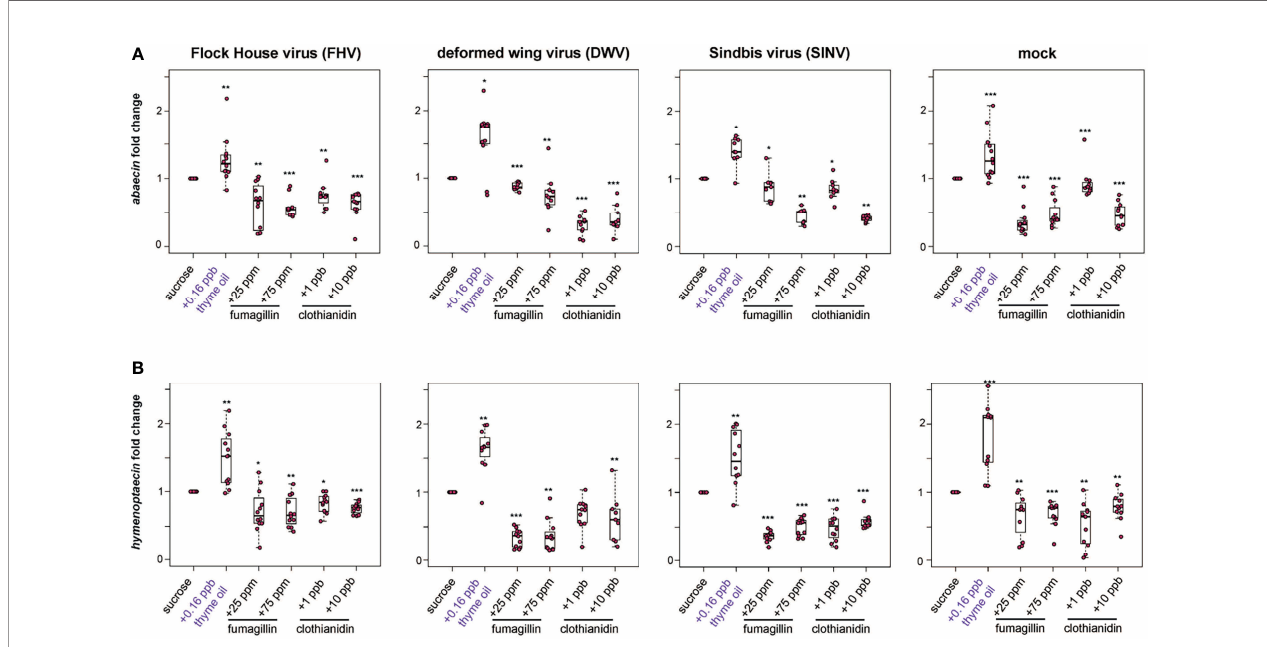
FIGURE 5 | Expression of antimicrobial peptides encoding genes was greater in bees fed thyme oil augmented sucrose syrup and lower in bees fed fumagillin or clothianidin containing sucrose syrup. The expression of two antimicrobial peptides ( abaecin and hymenoptaecin ) was assessed in mock and virus-infected bees fed sucrose syrup containing additives. (A) In virus- and mock-infected bees (i.e., FHV, DWV, SINV), abaecin expression was higher in bees fed sucrose syrup containing thyme oil and lower in bees fed sucrose syrup containing fumagillin (25 ppm or 75 ppm) or clothianidin (1 ppb or 10 ppb) compared to bees fed sucrose only. (B) In virus-infected bees (i.e., FHV, DWV, SINV), hymenoptaecin expression was higher in bees fed sucrose syrup containing thyme oil and lower in bees fed sucrose syrup containing fumagillin (25 ppm or 75 ppm) or clothianidin (1 ppb or 10 ppb). Hymenoptaecin expression was higher in mock-infected bees fed sucrose syrup augmented with 0.16 ppb thyme oil, but lower in mock-infected bees fed either fumagillin (i.e., 25 ppm or 75 ppm) or clothianidin (1 ppb or 10 ppb) containing sucrose syrup. Data were analyzed by a pairwise Wilcoxon Rank Sums with a Benjamini – Hochberg correction for multiple comparisons. Asterisks indicate a signi fi cant change in gene expression compared to sucrose only control; signi fi cance levels: * p < 0.05; ** p < 0.005; *** p < 0.0005. This fi gure shows representative biological replicate for the expression of each gene (i.e., rep1 for abaecin and rep3 for hymenoptaecin ). The data for one additional biological replicate is presented in Supplemental Figures S7 , S8 . Raw data are included in Supplemental Tables S17 – S20